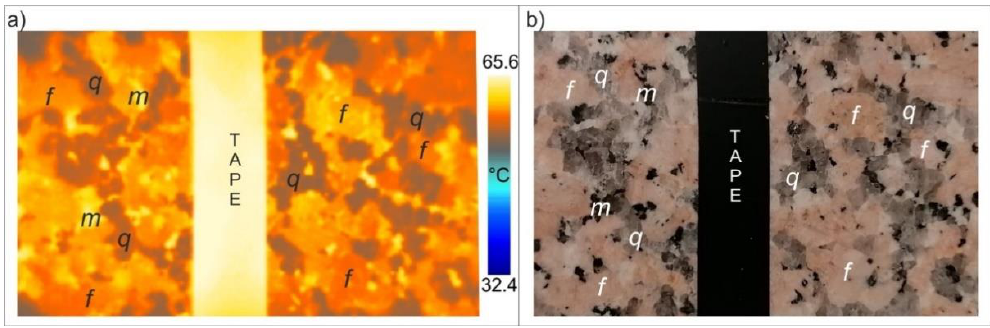
Figure 6. ( a ) IRT image of a granite highlighting the different thermal behavior offered by minerals, m — micas, f — feldspars, q — quartz; ( b ) digital image of the corresponding granite.